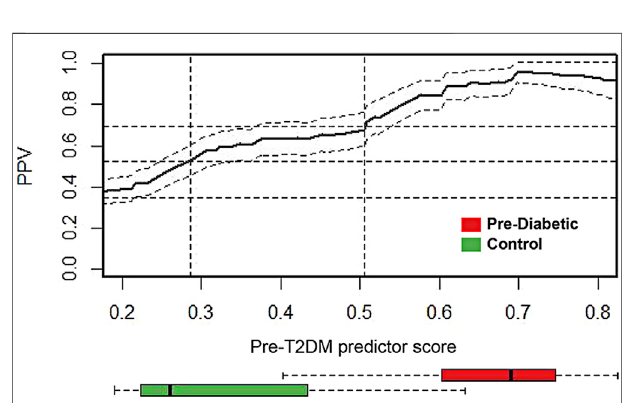
FIGURE 6 | Prevalence-corrected positive predictive values (PPV) was plotted as a function of Pre-T2DM predictor score for the Pre-T2DM cohort samples. Horizontal dashed lines identify the average population risk of 34.8%, and relative risks of 1.5X (52.2%) and 2X (69.6%). Vertical dashed lines identify corresponding predictor scores. The con fi dence interval about the PPV curve (gray shaded area) was estimated using all Pre-T2DM subjects. Con fi dence intervals about the PPV were calculated with the normal approximationoftheerrorforbinomialproportions. Boxplotsatthefootofthe fi gure correspond to the distributions of predictor scores for prediabetic and control subjects. The PPV curve and the box plots share the same predictor score